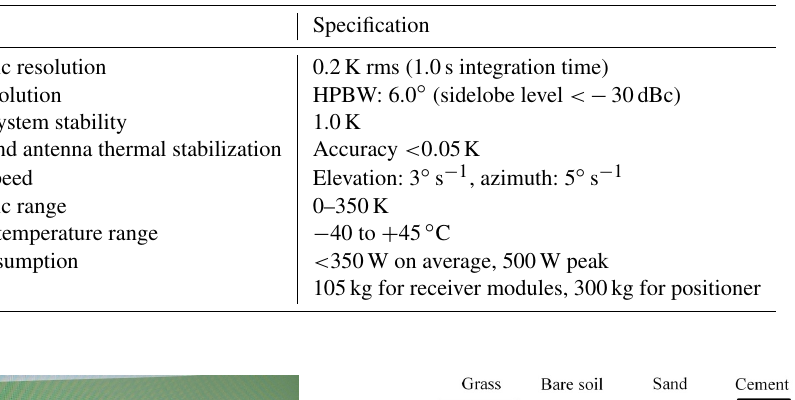
Table 1. Instrument specifications.